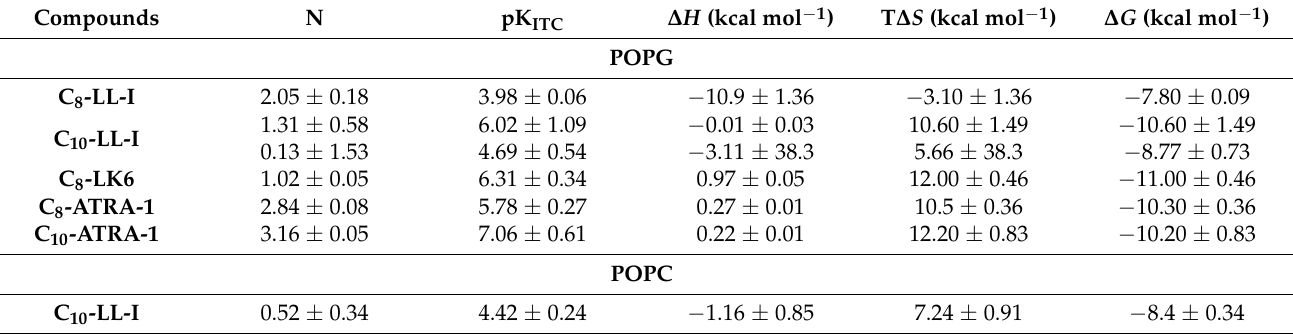
Table 4. Thermodynamic parameters of lipopeptide binding to POPC and POPG